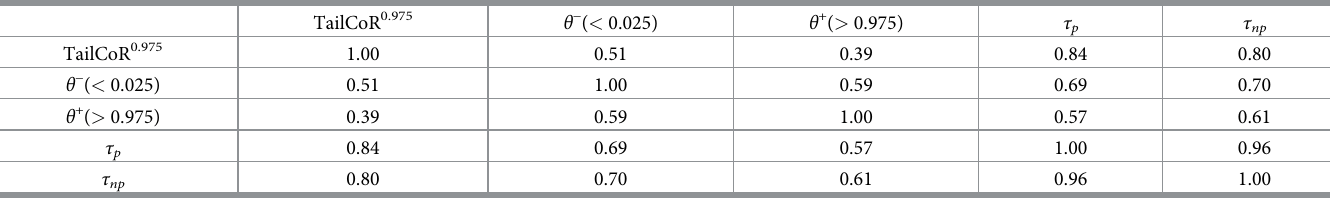
estimates, and calculating the Pearson correlations between